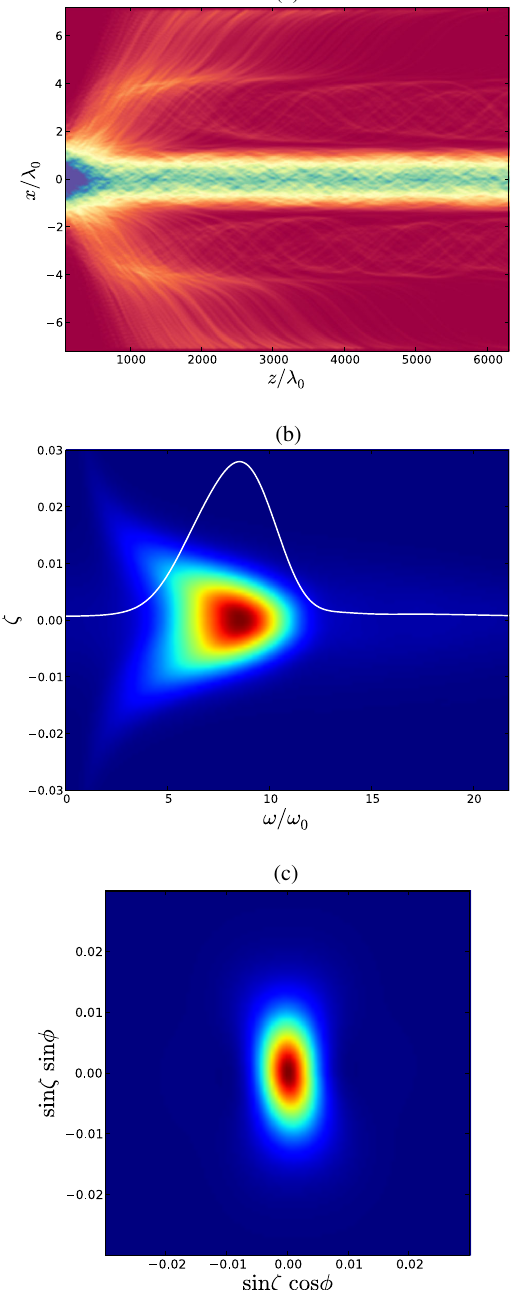
FIG. 5. Trajectories of electron propagation in the optical lattice, the length of injection zone is 20 wavelengths (a). Angular-spectral distribution of emitted radiation in the (cid:12) ¼ (cid:8)= 2 plane and its on-axis spectrum (white curve) (b), and the frequency-integrated angular distribution